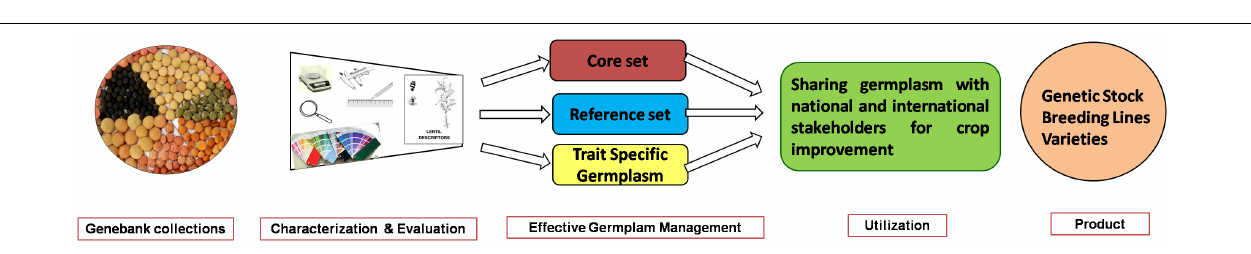
FIGURE 11 | Flowchart depicting the stepwise utilization of Indian national genebank lentil